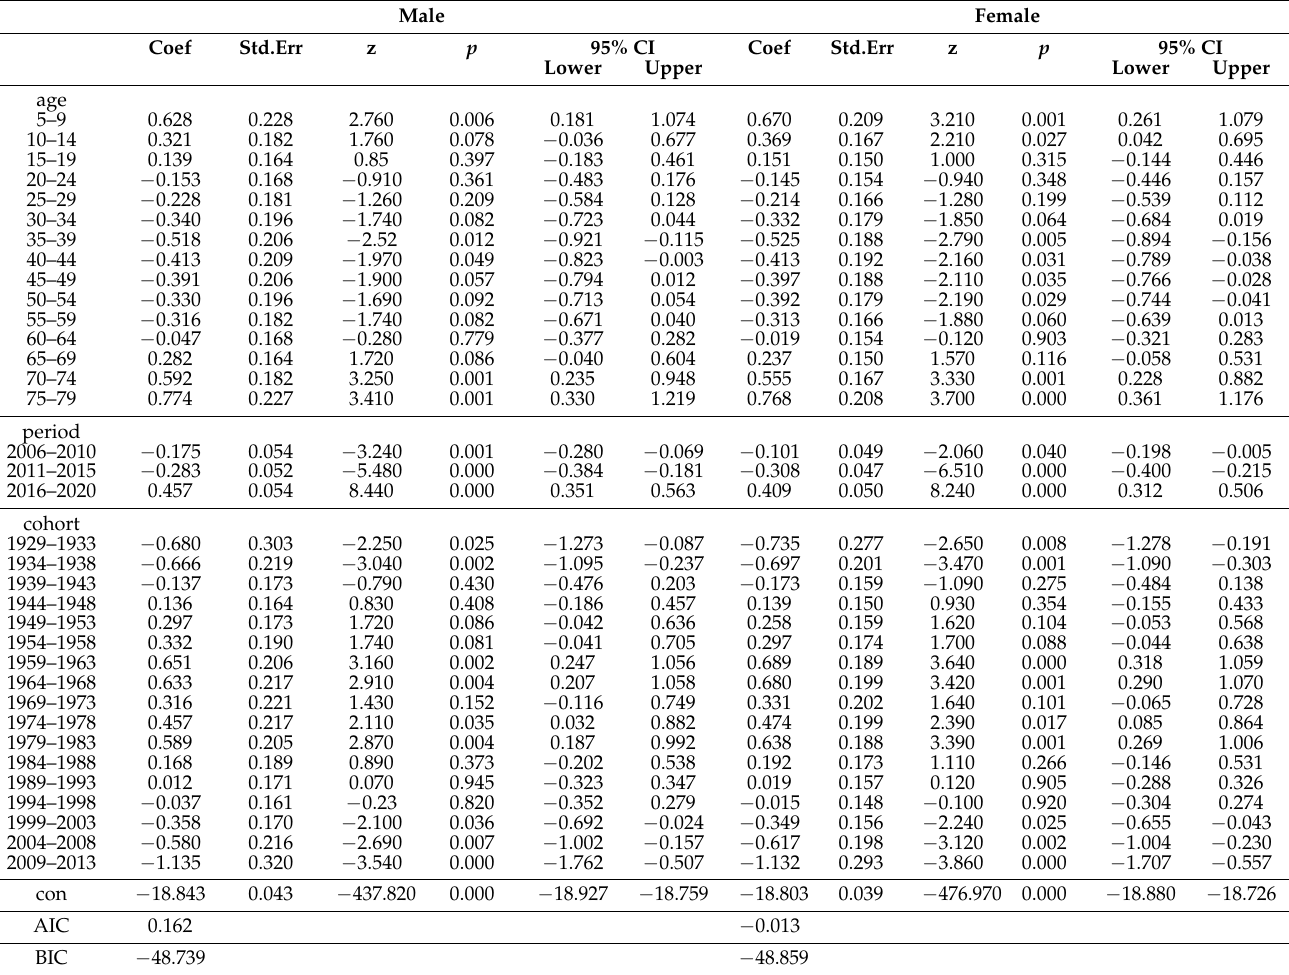
Table A4. Age–period–cohort analysis of injury and poisoning mortality rates for men and women in rural China,